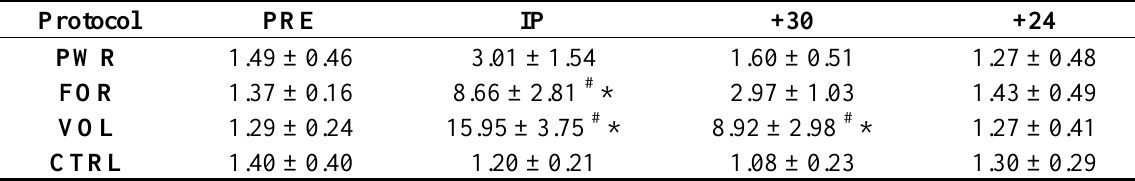
Table 1. Lactate responses (mmol L −1 ) to protocols prior to exercise (PRE), immediately post (IP), at 30 min post (+30), and at 24 h post (+24). Please note lactate levels immediately post exercise (IP), where pairwise differences exist between all protocols with the exception of CTRL and PWR. The VOL protocol is a source of particular physiological stress (IP 15.95 ± 3.75 mmol L −1 ). # significant difference from resting and * significant difference from all other protocols at 0.05 level.